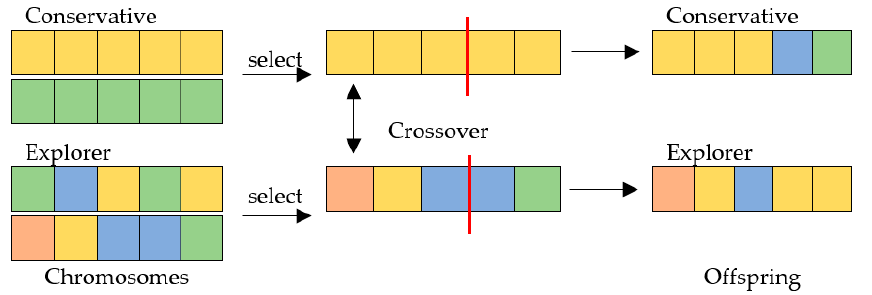
Figure 6. Crossover operation in an MSGA.